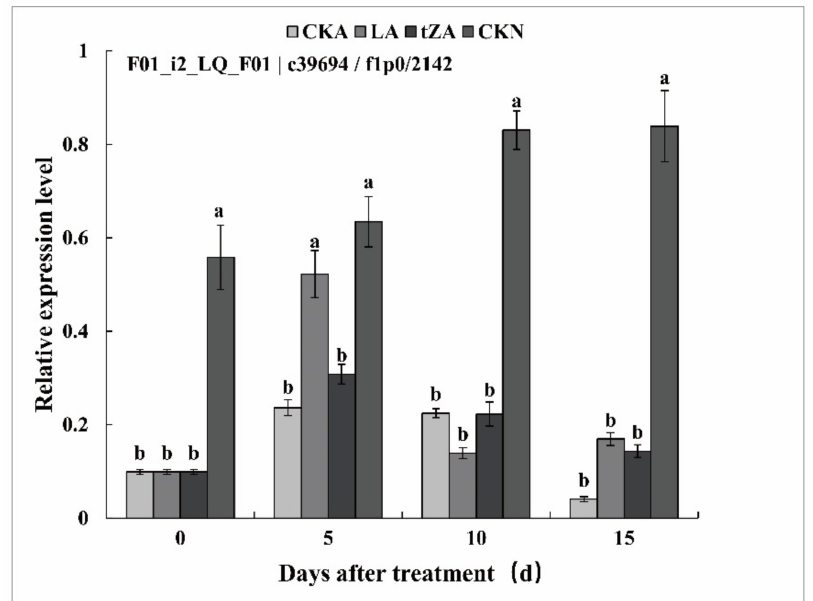
Figure 12. The relative expression level of CAT related gene in CKN, CKA, tZA and LA groups after the treatment. Different lower-case letters among different treatment groups indicate significant differences based on one-way analysis of variance in SPSS 21.0 followed by the Duncan’s test ( p <